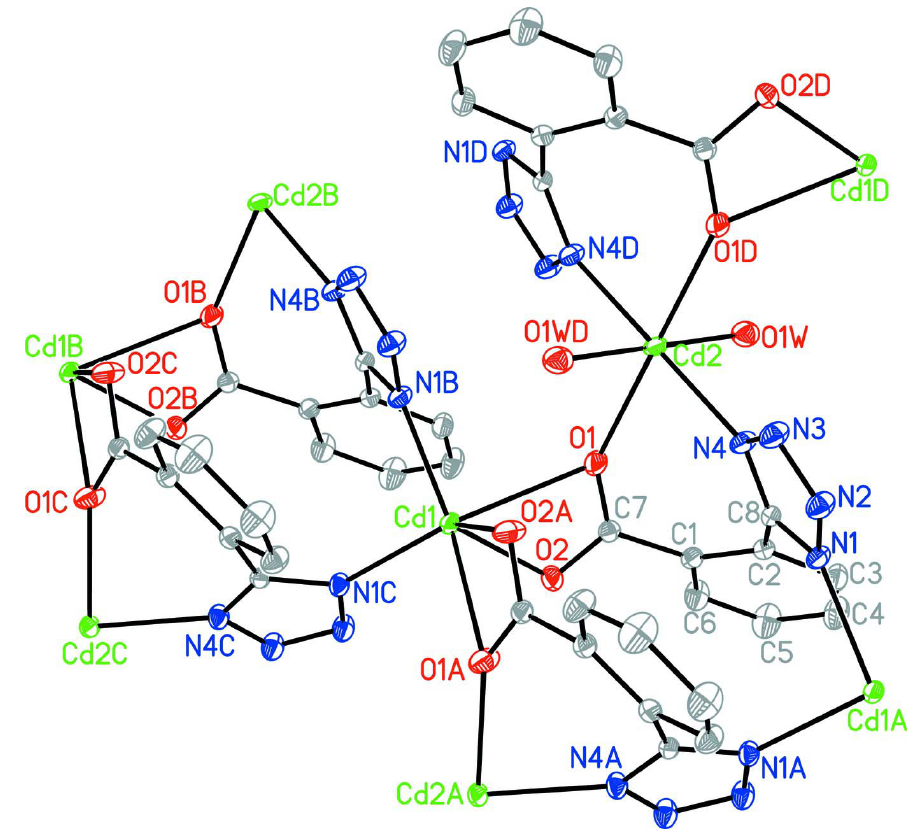
Figure 1 A partial packing diagram of the title compound, with displacement ellipsoids drawn at the 30% probability level. H atoms have been omitted for clarity. [Symmetry codes: (A) - x, - y + 1, - z ; (B) - x, +y, 1/2 - z ; (C) +x, +y - 1, +z ; (D) - x, +y - 1, 1/2 - z